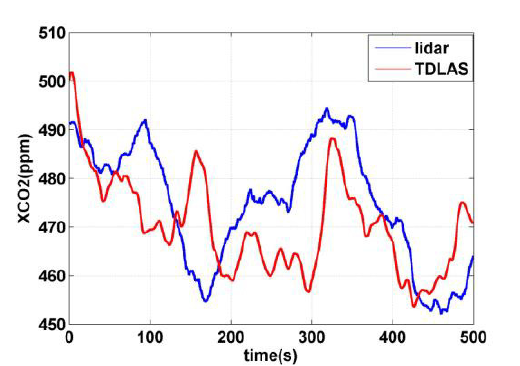
Figure 7 Ratio of on-line and off-line normalized echo signal